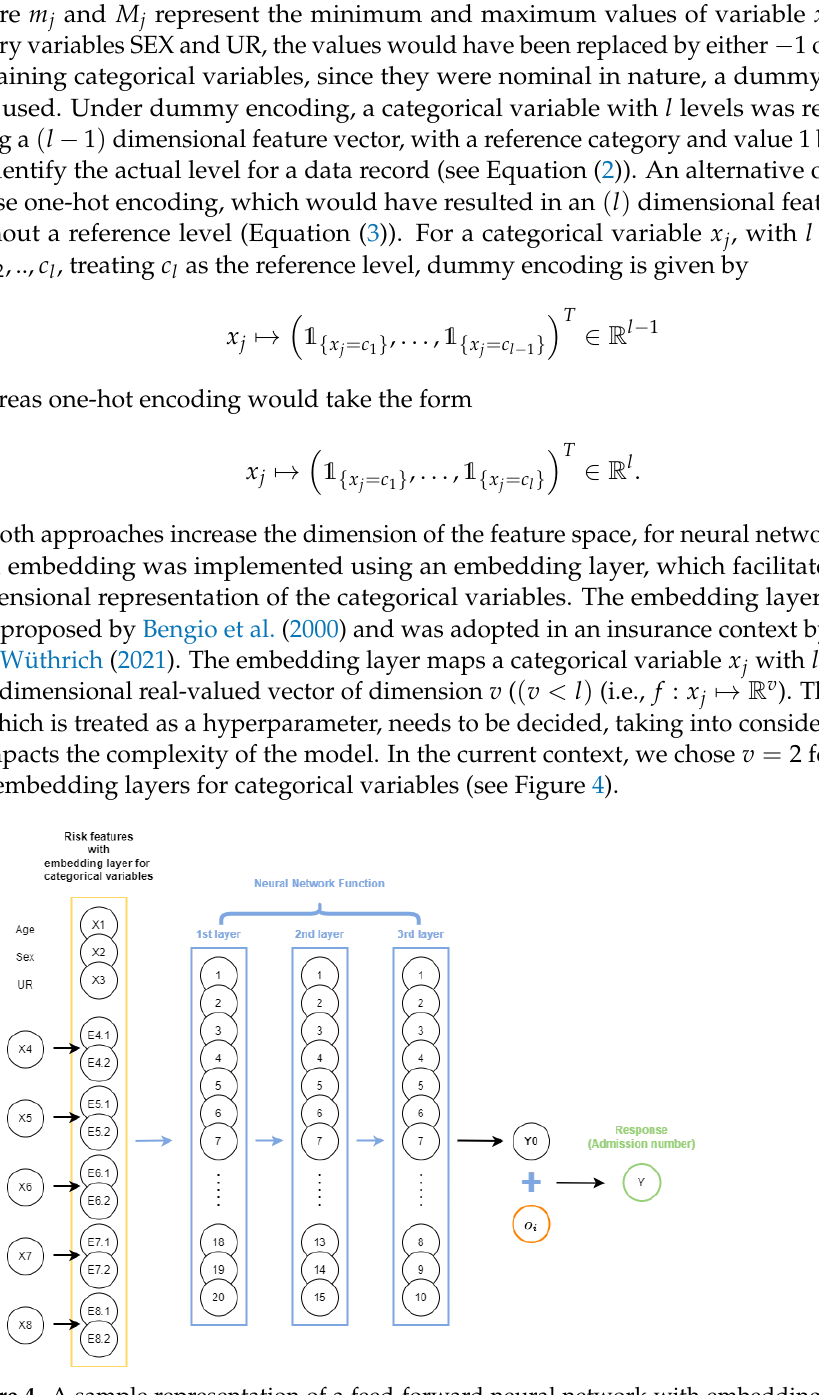
Figure 4. A sample representation of a feed-forward neural network with embedding layers and three hidden layers with 20,15,10 neurons in each